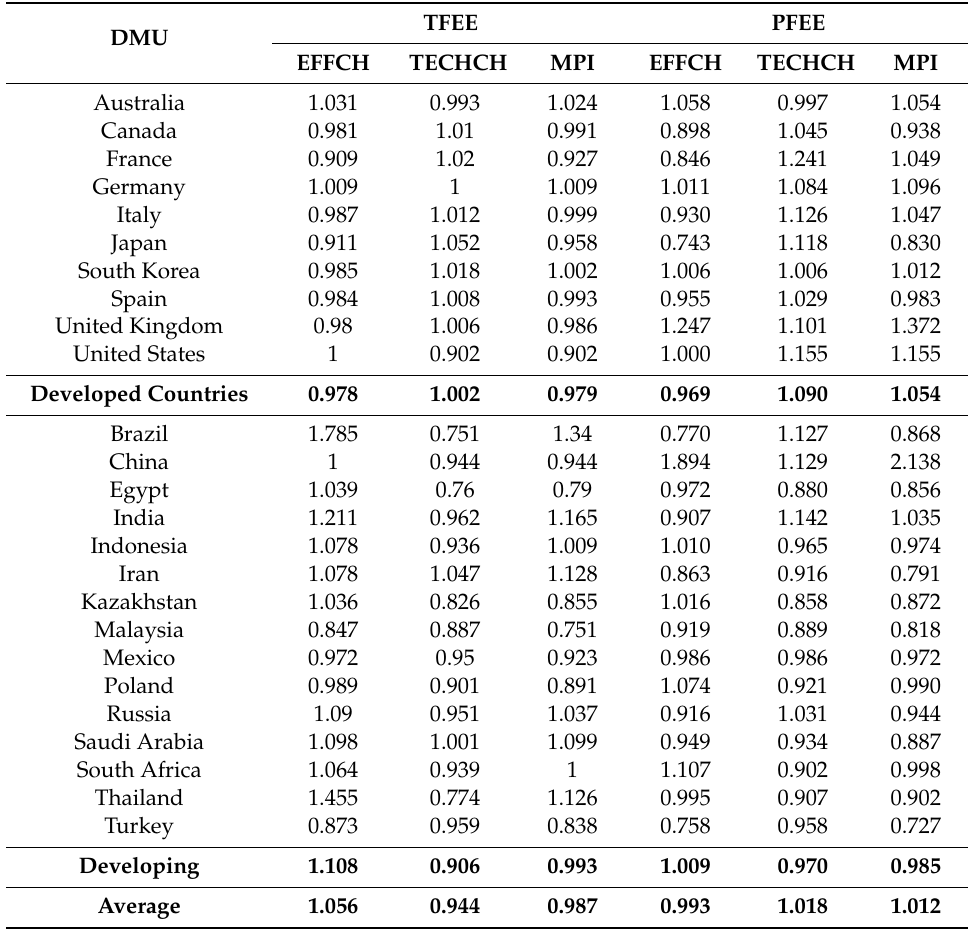
Table 4. Energy e ffi ciency improvement during